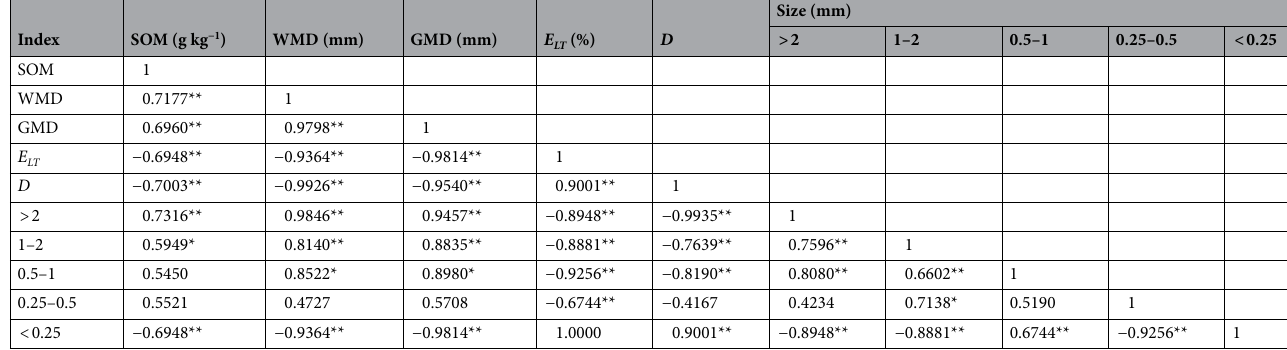
Table 2. Correlation analysis between SOM and water-stable aggregates parameters. SOM, soil organic matter; GMD, geometric mean diameter; MWD, mean weight diameter; E LT , unstable aggregate index; D , fractal dimension. * means significant correlation at 0.05 level; ** means highly significant correlation at 0.01